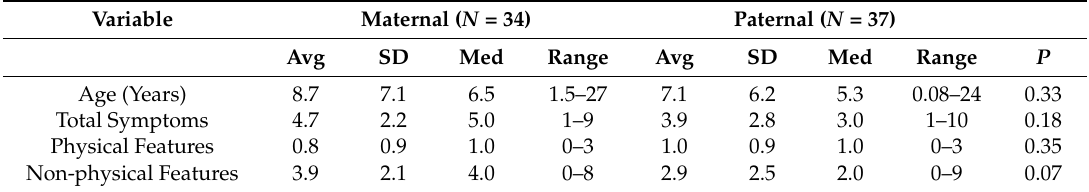
Table 2. Descriptive statistics of parental inheritance of individuals with the 15q11.2 BP1-BP2 microdeletion.